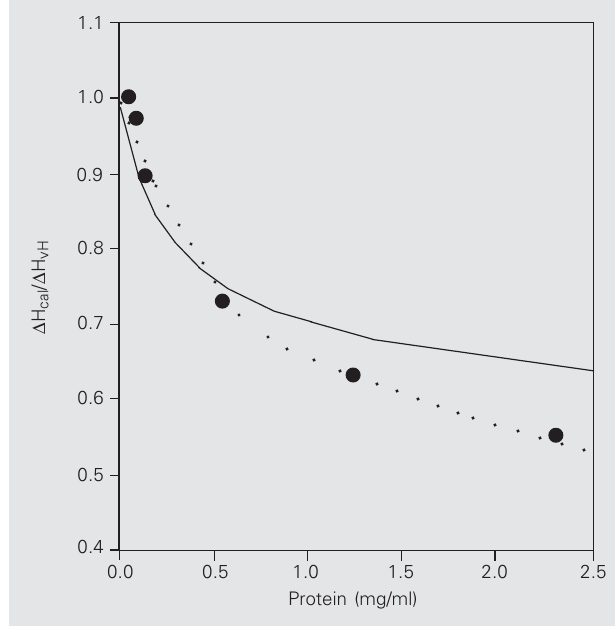
Figure 4. ∆ H cal / ∆ H vH values for ß-trypsin at pH 3.70 as a function of protein concentration. The buffer was 50.0 mM ß-alanine and 20.0 mM CaCl 2 , pH 3.70. Dotted line = fourth degree polynomial fitted to the data to guide the eyes. Solid line = equation 5 fitted to the data to show the predicted values due to a putative dimerization process. Protein concen- tration was 0.05 to 2.3